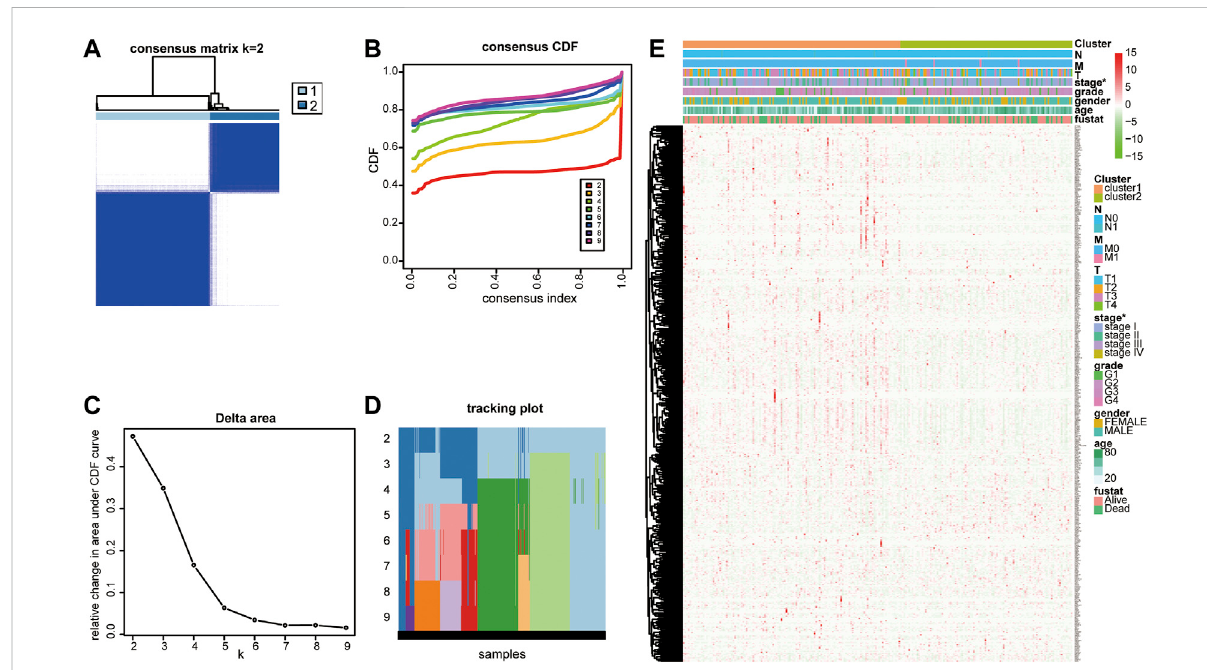
FIGURE 2 Consensus clustering identi fi ed two lipid metabolism-associated gene subgroups. (A) Consensus clustering matrix for k = 2. (B) Consensus clustering cumulative distribution function (CDF), (C) the relative change of area under the CDF curve and (D) tracking plot from k = 2 to 9. (E) Heatmap of correlation between lipid metabolism-associated genes with clinicopathological characteristics of HCC patients.